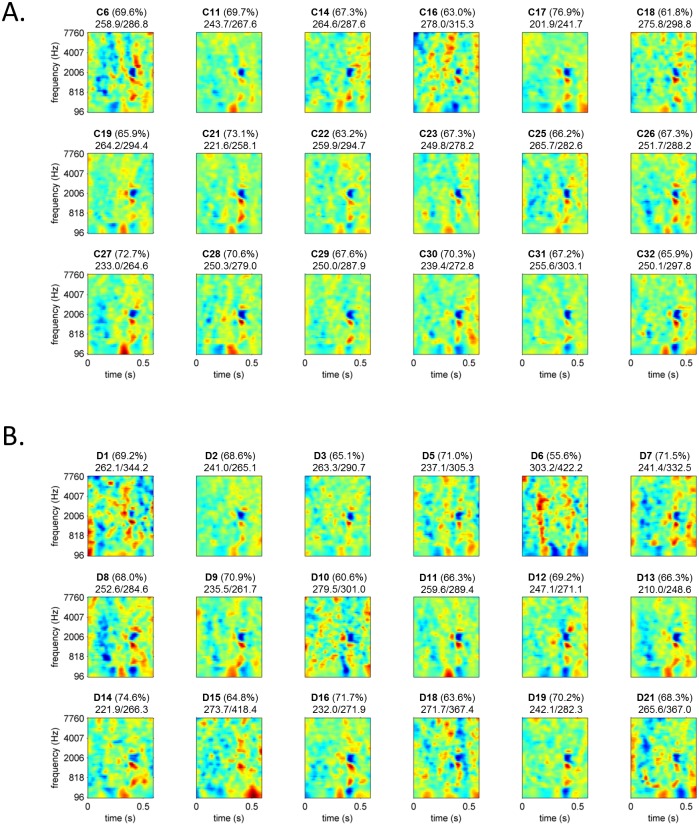
Individual ACIs for all control (A.) and dyslexic (B.) participants.For each ACI the auto-prediction rate is given (in brackets), followed by the auto- and cross- prediction deviances. Positive weights (in red) are time-frequency bins where the presence of noise increases the probability that the listener gives the response “da” whereas negative weights (in blue) are time-frequency bins where the presence of noise increases the probability that the listener gives the response “ga”.